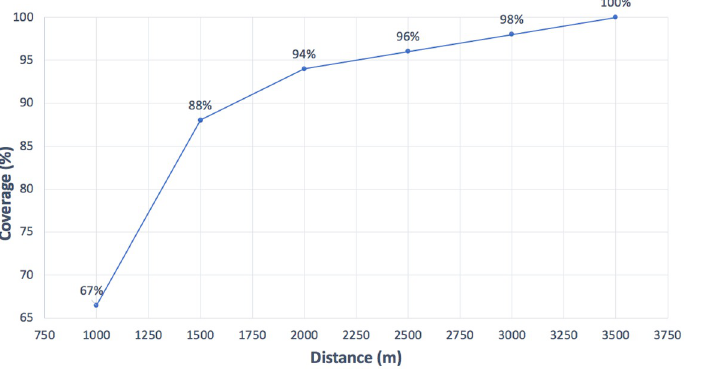
Fig 2. Coverages for the different distances of the 2010 actual schools